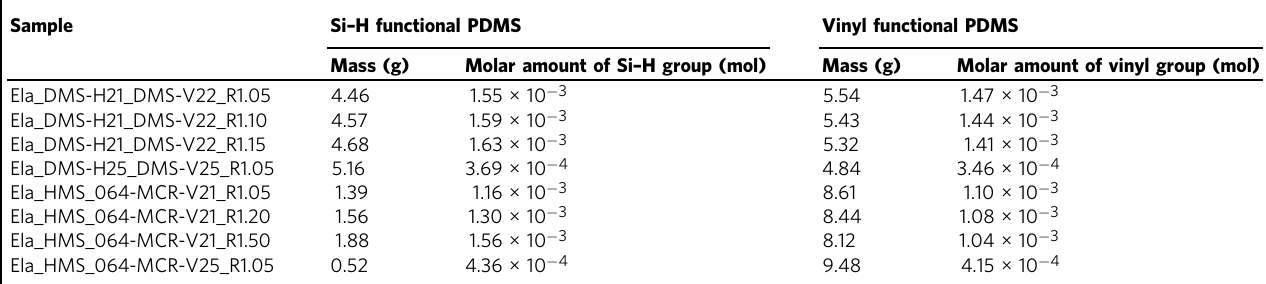
Table 5 Formulations of preparing highly stretchable and extremely soft silicone elastomers.